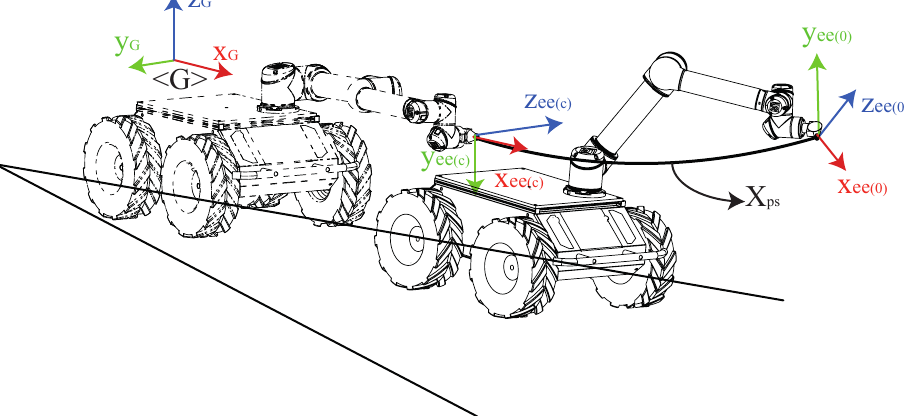
Figure 5. Stabilization point of the end-effector of the mobile manipulator. The actual position of the end-effector towards the starting point of the desired